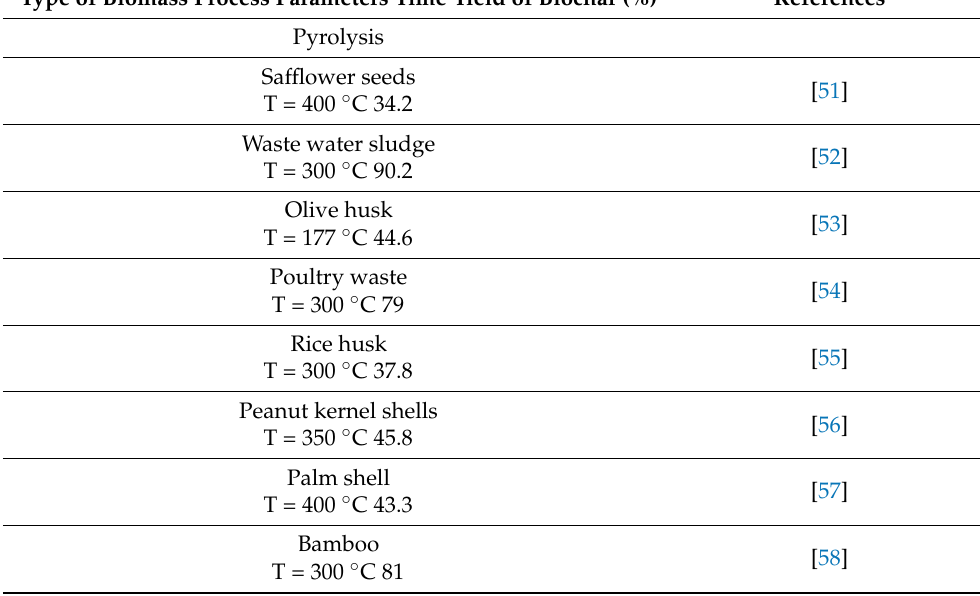
Table 2. Biochar yield from a variety of biomass sources using pyrolysis and hydrothermal carboniza- tion